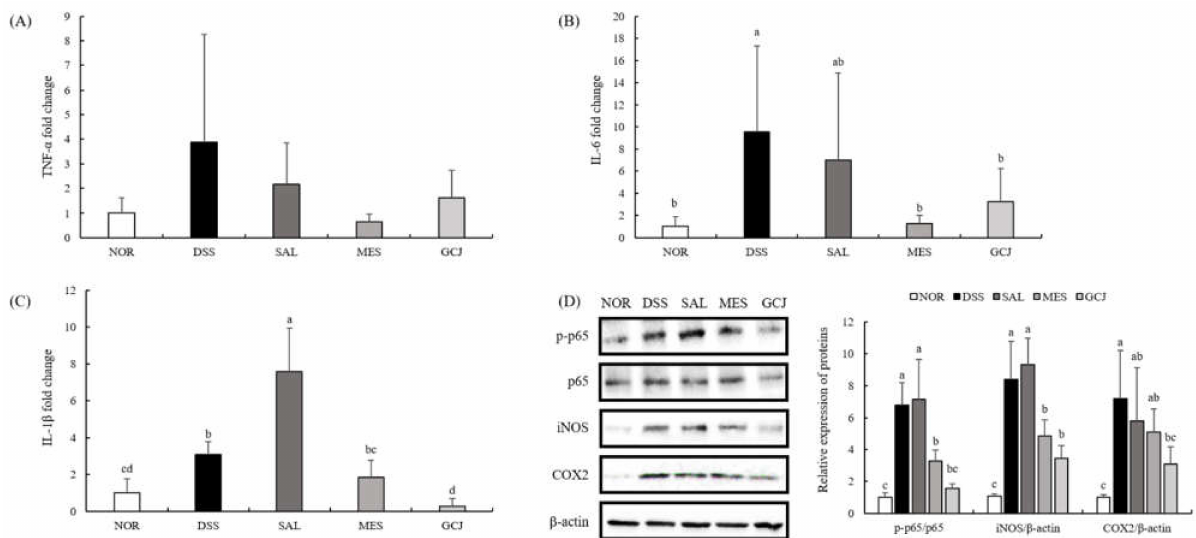
Figure 3. Effects of Gochujang on immune response in colon tissue of DSS-treated rats. ( A – C ) mRNA expression of colonic pro-inflammatory cytokines (TNF-a, IL-6, and IL-1 β ); ( D ) expression of inflammatory proteins. Data are expressed as the mean ± SD ( n = 7 per group). Values with different superscripts (a, b, c, d) are significantly different among groups according to ANOVA with Duncan’s multiple range test at p <